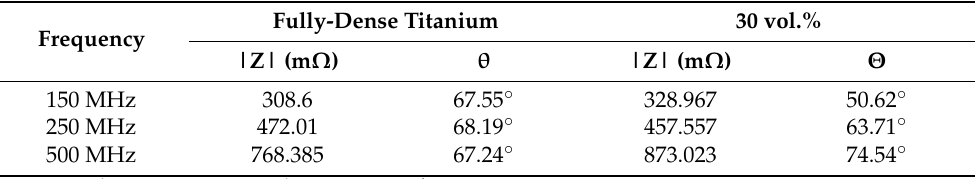
Table 3. Impedance modulus and phase values for different titanium samples with osteoblast cell cultures